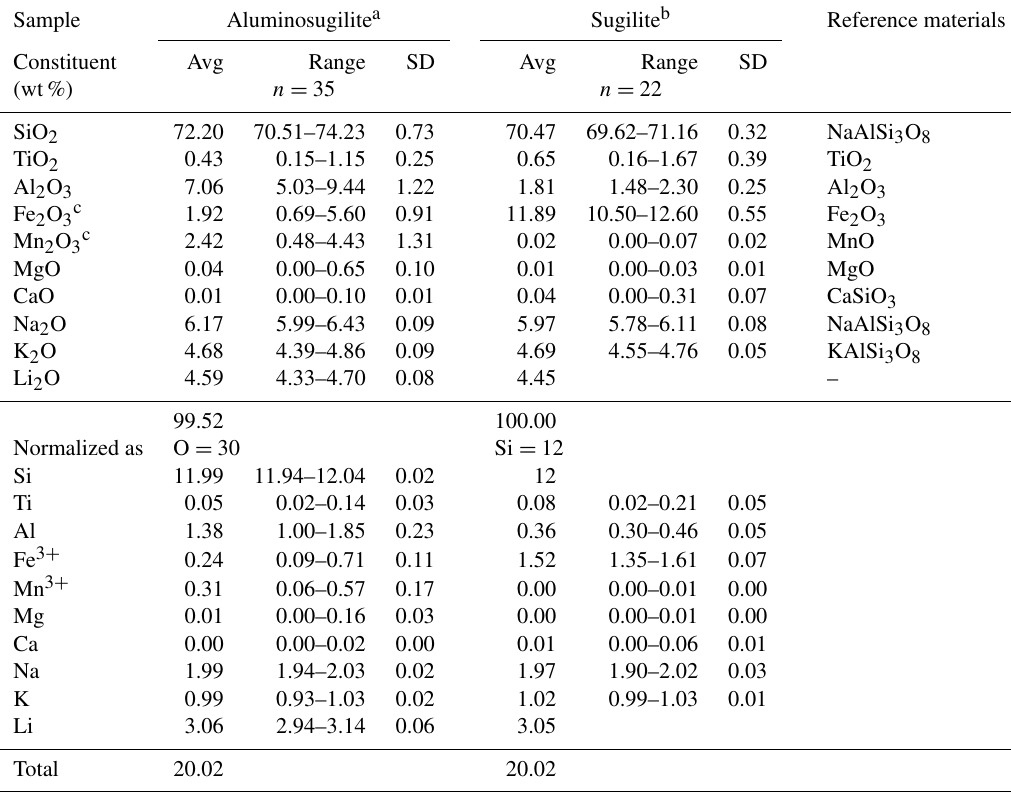
Table 1. Chemical compositions of aluminosugilite and sugilite, in addition to reference materials. Sample Aluminosugilite